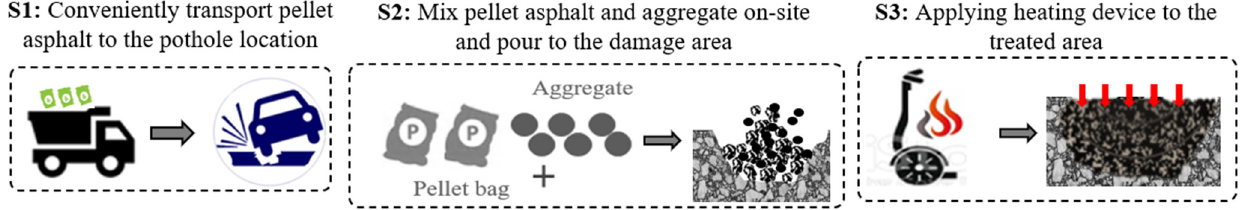
Figure 4. Pellet-type asphalt pavement is applied to the emergency pothole repair site.